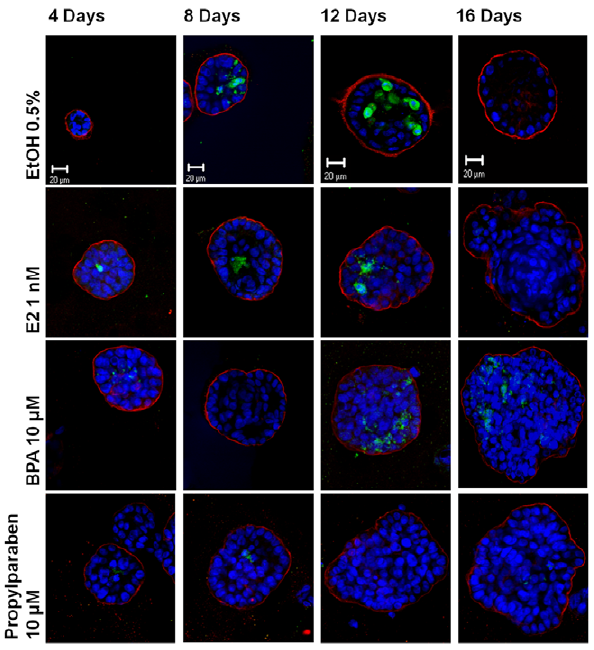
Figure 4. Time-course analysis of the formation of MCF-12A acini cultured in matrigel in the presence of the test chemicals. Cells were either treated with solvent (ethanol 0.5%) or with 1 nM E2, 10 m M BPA or 10 m M propylparaben and allowed to grow for 4, 8, 12 and 16 days. The resulting structures were immunostained with antiserum to laminin V (red) to delineate the secretion of basement membrane, activated caspase-3(green) to detect apoptotic cells and counterstained with TO-PRO 3 to visualize the cell nuclei. Confocal images are representative of 3 independent experiments.